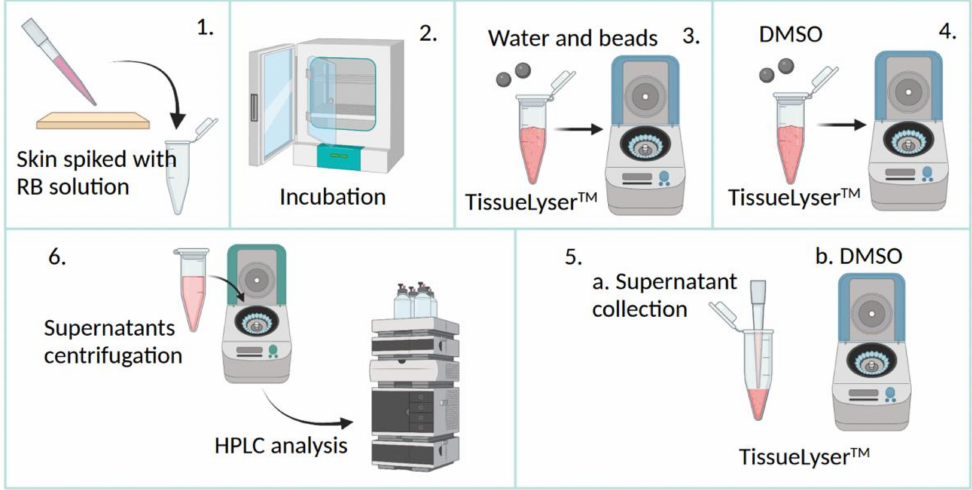
Figure 2. Schematic illustration of the skin extraction recovery process. RB: Rose Bengal; DMSO: dimethyl